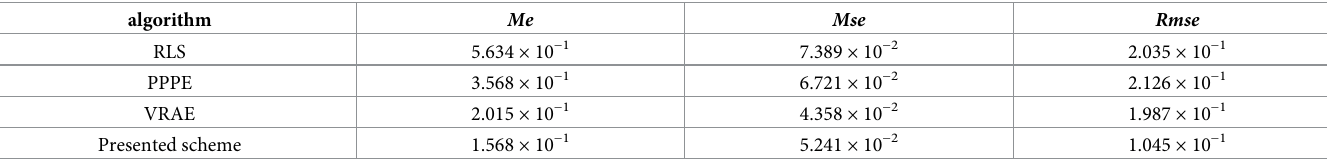
Table 1. Quantitatively indices for